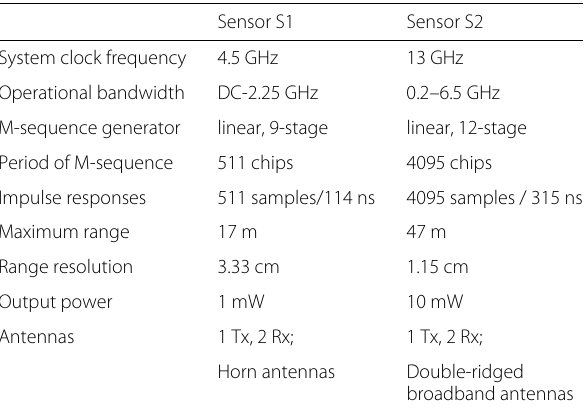
Table 1 Basic parameters of the sensors